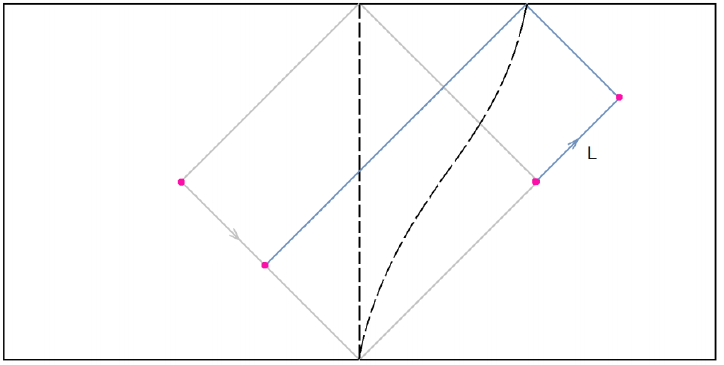
Figure 16. Two-dimensional de Sitter spacewith two static patches related by a light-like generator L